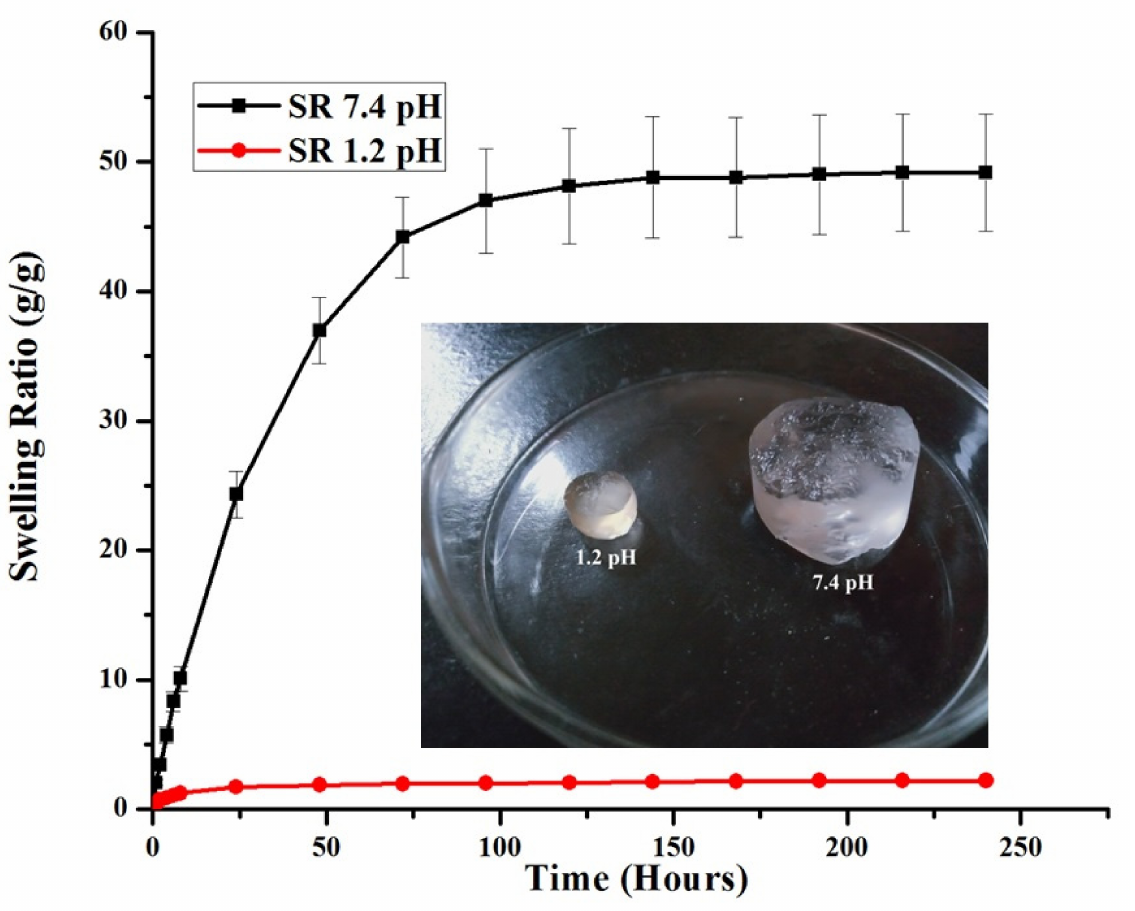
Figure 6. Equilibrium SR and physical appearance of AG-1 at pH 1.2 (red) and 7.4 (black). Data are presented as means ± SD ( n =